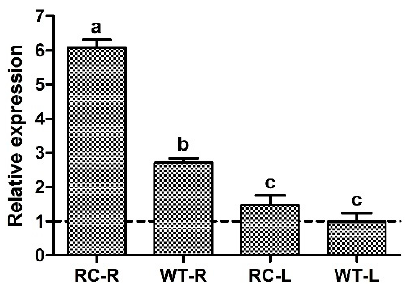
Figure 1. qPCR analysis of the gene expression level for Calcineurin B-like interacting protein kinase 2 ( CIPK2 ). RC-R: Root of transgenic plants; WT-R: Root of wild type; RC-L: Leaf of transgenic plants; WT-L: Leaf of wild type. Small letters represent significant di ff erence at ( p < 0.05) calculated by Least Significance Di ff erence (LSD)